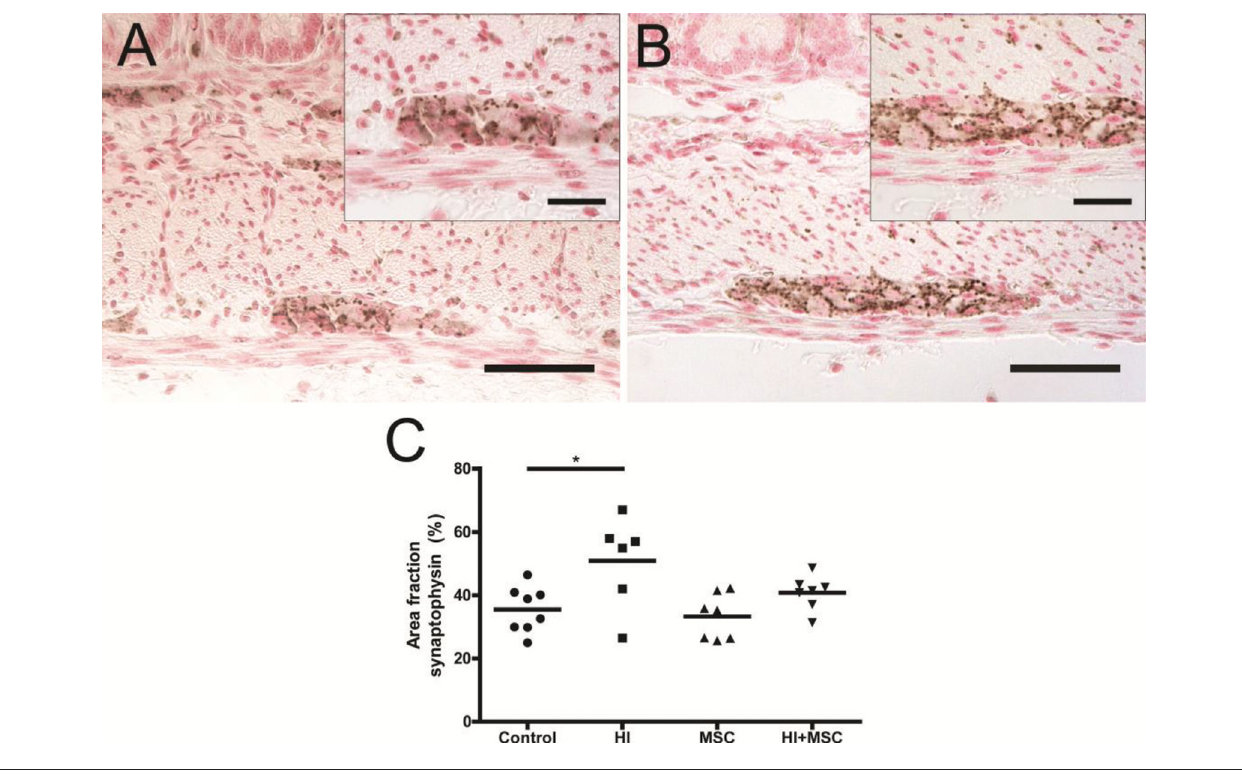
figure 9. Increased expression of synaptophysin in myenteric ganglia 7 d after HI. Representative intestinal sections of (A) control and (B) HI animals were stained by immunohistochemistry for synaptophysin. For each experimental group, the synaptophysin-positive area in myenteric ganglia was measured and the mean area fraction (%) per ganglion per animal is given (C). The scale bar in panels A and B represents 50 μ m. The scale bar in insets represents 20 μ m. * p <